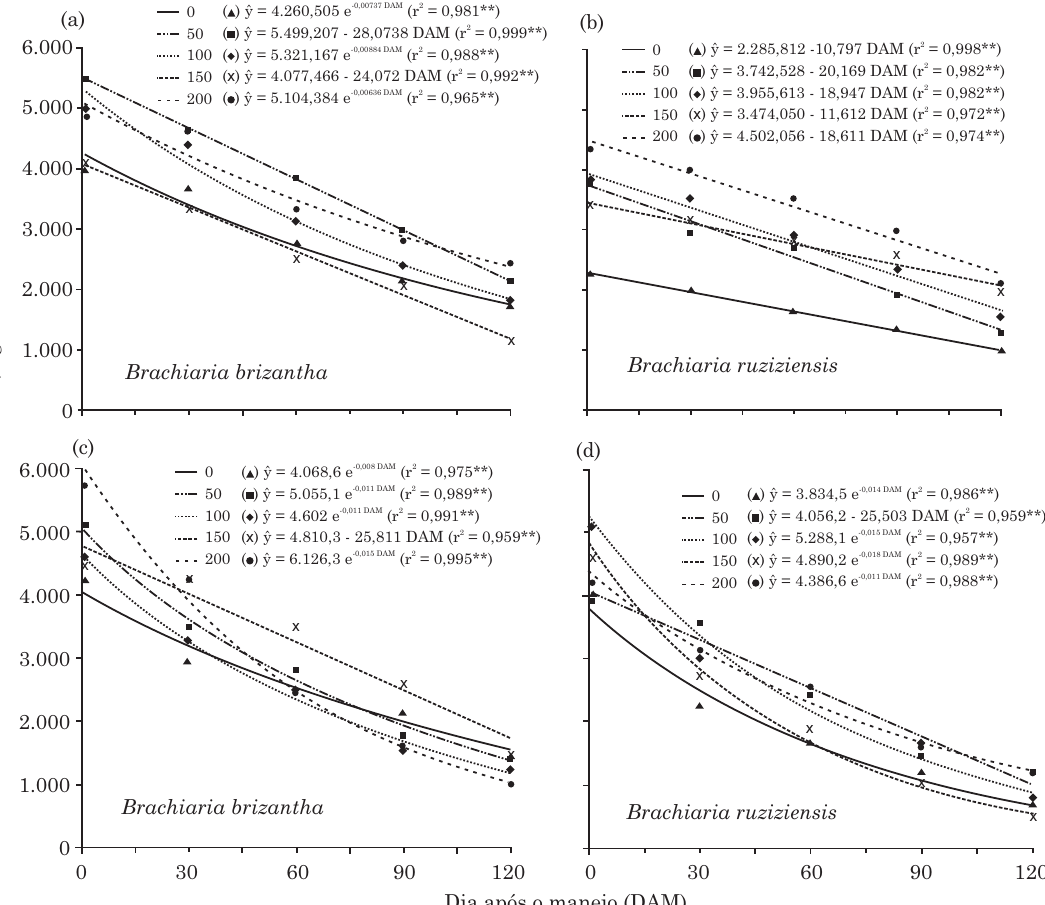
Figura 2. Decomposição da massa seca residual (palhada) das espécies de Brachiaria após a dessecação e o manejo de corte, em função da adubação nitrogenada, em que (a) e (b) são safras de 2008/2009; e (c) e (d), de 2009/2010. ** : significativo a 1 % pelo teste